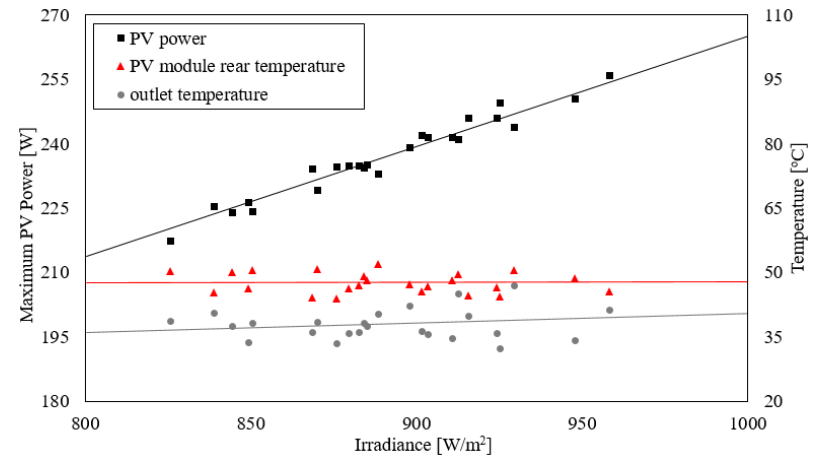
Figure 7. Effect of PV power and temperature by irradiance.